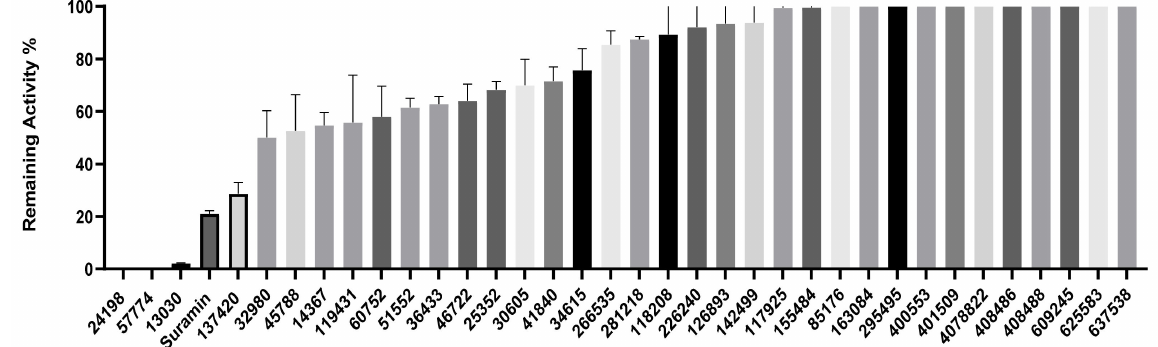
Figure 3. Remaining activity (%) of the SHP2 enzyme after treatment with the 35 tested compounds (at 100 µ M) along with the control suramin. Data presented are the mean +/ − SEM of three independent